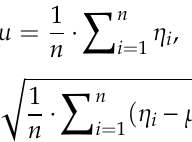
Table 6. Material constants for the description of c , n, and k parameters.